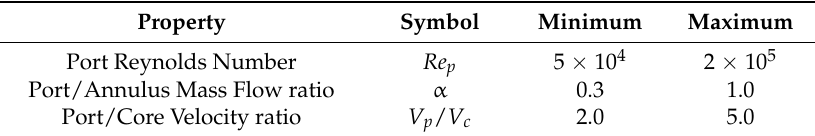
Table 4. Range of flow conditions tested.